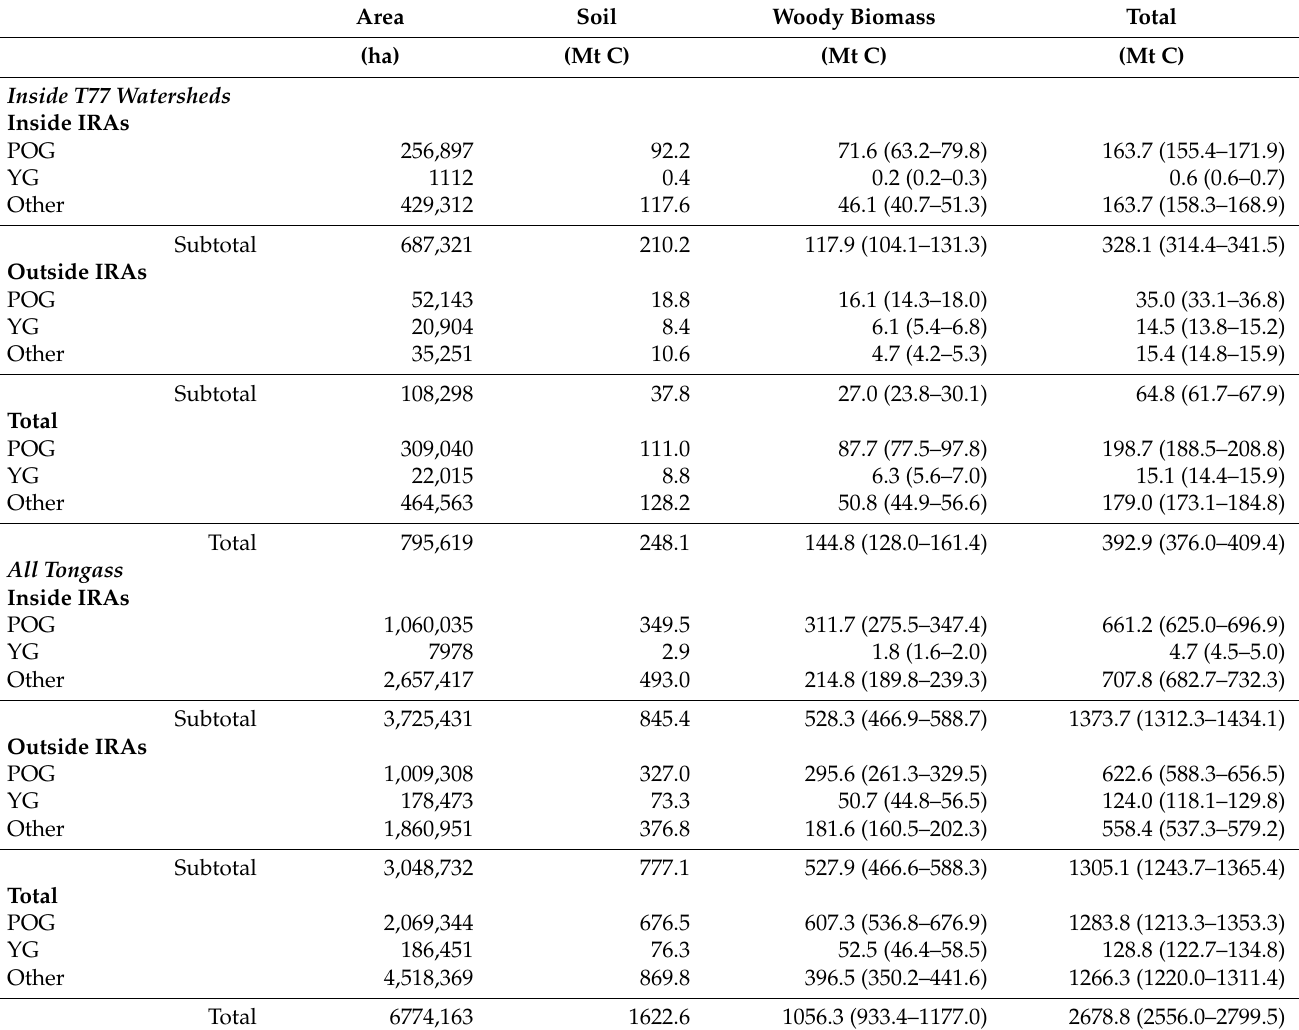
Table 2. Carbon stocks (million metric tons) in woody plant biomass and soil organic matter by forest age class (productive old growth vs. young growth) inside and outside of Inventoried Roadless Areas (IRAs) and within the T77 watersheds in the Tongass National Forest, southeast Alaska. POG = Productive Old Growth; YG = Young Growth. Values in parentheses indicate ranges (lower and upper bounds). Biomass was scaled [25] to determine lower and upper bounds using the range of ratios between the live trees measured by Forest Inventory Analysis (FIA) plot data and the other C pools (excluding soils) [12]. Soil was not scaled (see [28]), hence the lack of ranges. Area Soil Woody Biomass Total